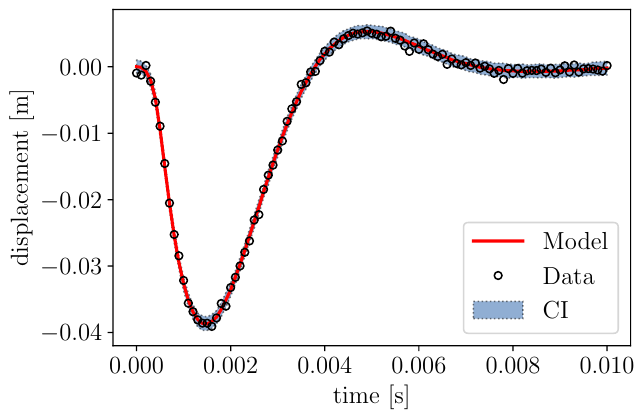
Figure 10. The prediction of the surrogate model and its confidence interval due to uncertainty propagation of the variability in the estimated inner